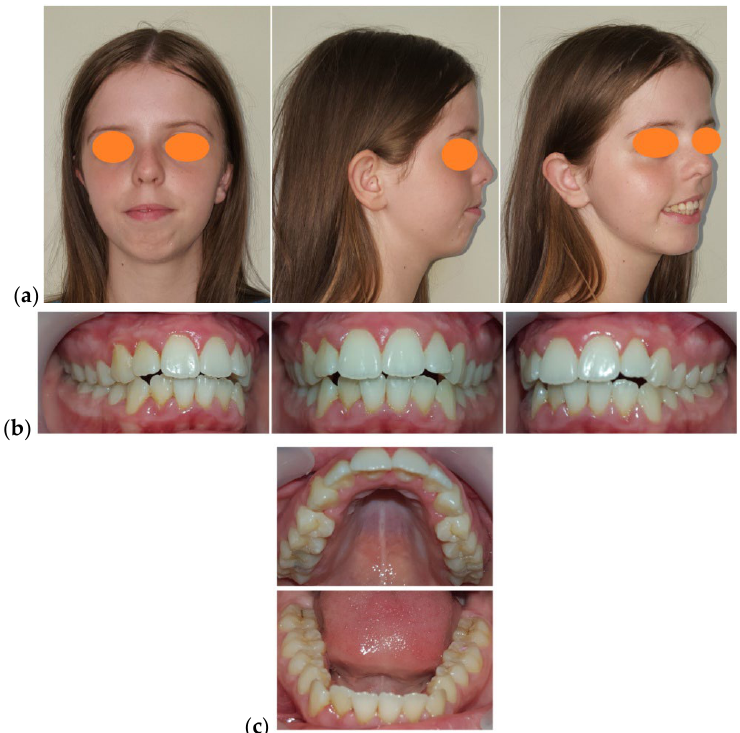
Figure 1. Initial photographic examination: ( a ) Facial aspect: frontal view, profile, ¾ profile on smiling. ( b ) Intra -oral aspect: lateral right, frontal, and lateral left. ( c ) Intra -oral aspect: occlusal view.